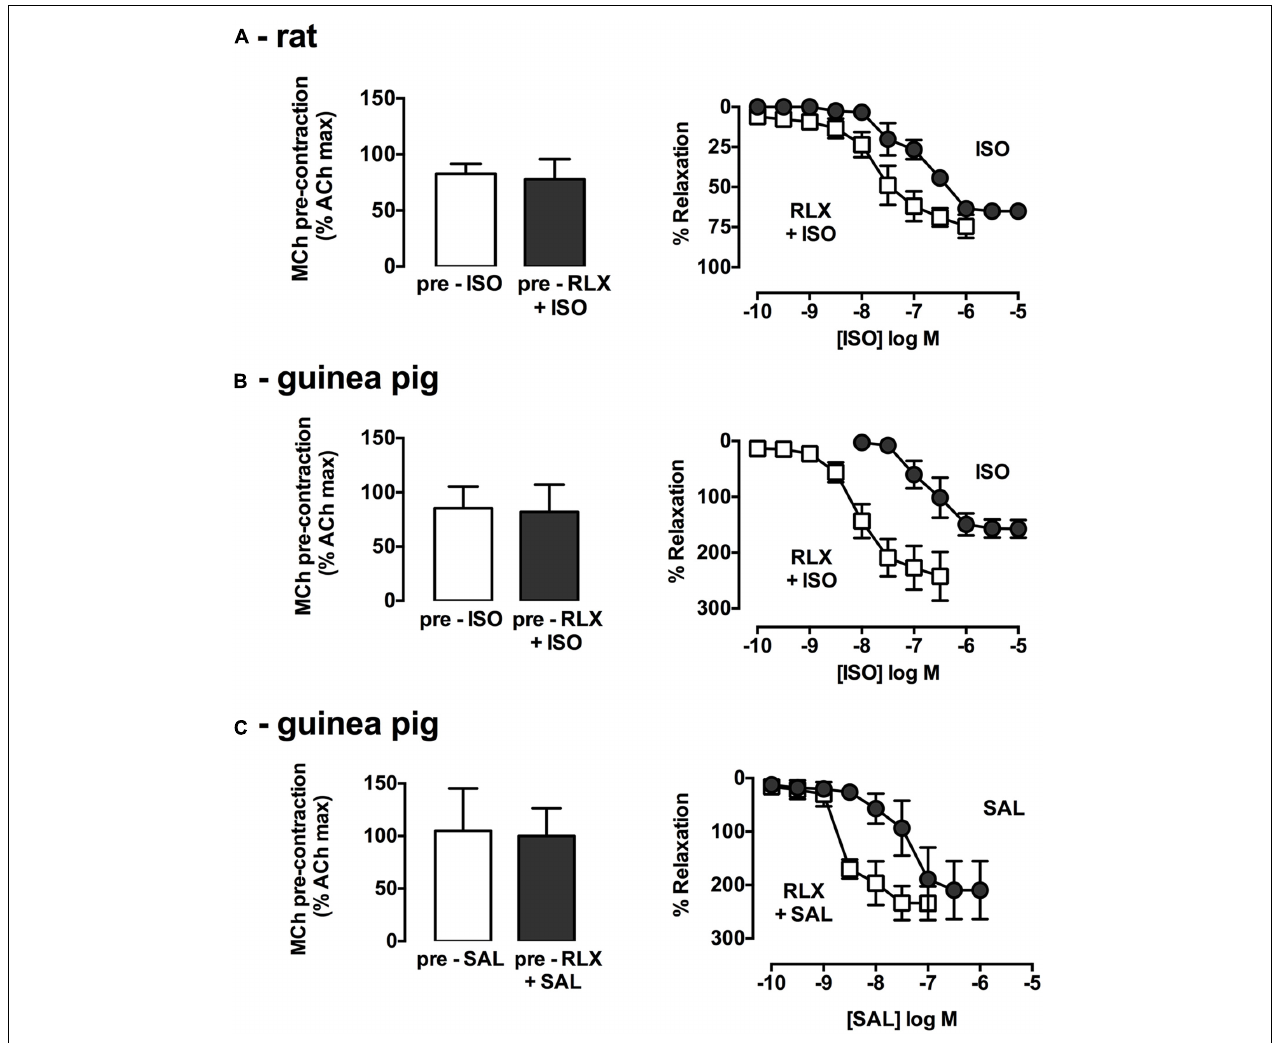
FIGURE 2 | rhRLX potentiates relaxation to β -adrenoceptor agonists. Trachea were precontracted with MCh, prior to measurement of relaxation responses in the absence and presence of rhRLX (100 nM) to ISO (0.001–10 µ M) in (A) rat and (B) guinea pig trachea or SAL (0.001–10 µ M) in (C) guinea pig trachea. Extent of relaxation is expressed as % of submaximal MCh pre-contraction (mean ± SEM for n = 4–5 per